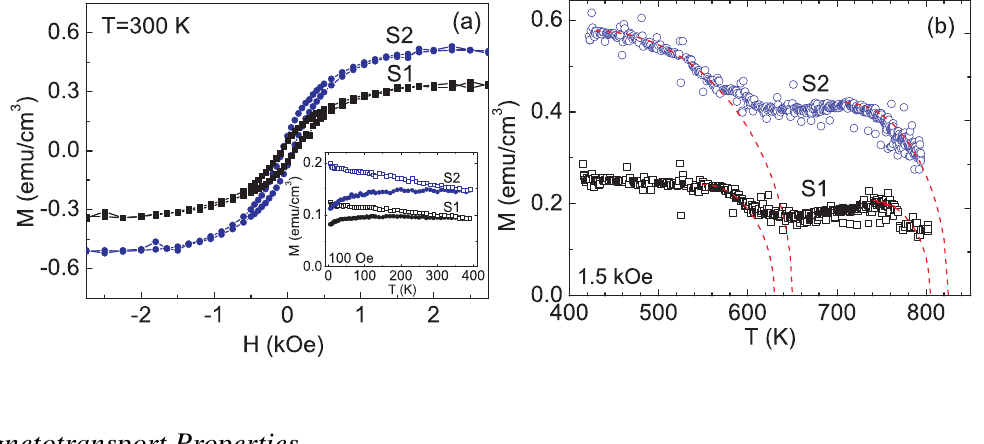
(T) = M [1-(T/T )2]1/2. s 0 C